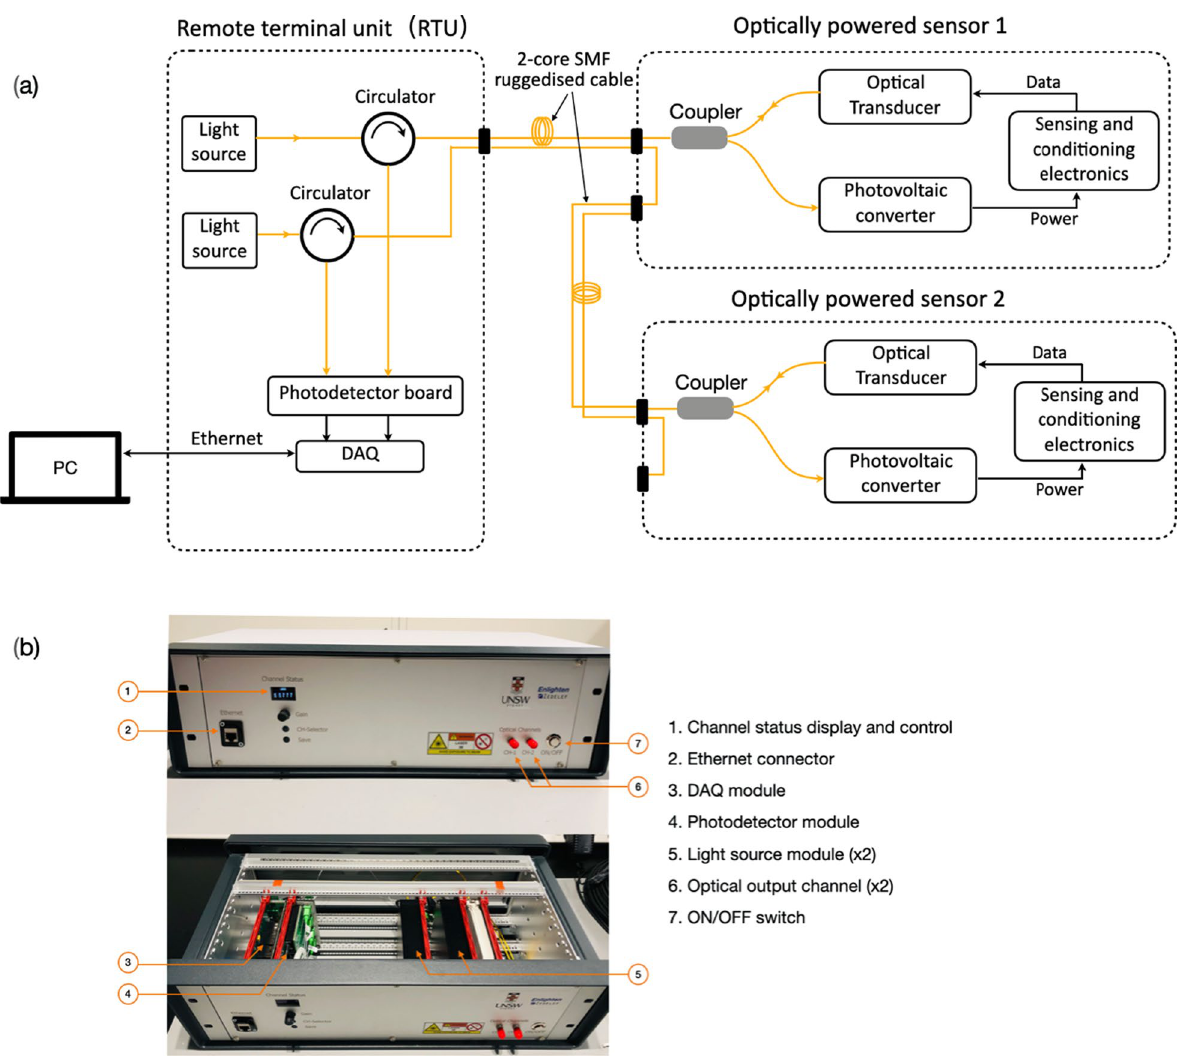
Fig. 4 RTU block diagram and its connection with two optically powered sensors (in daisy-chain configuration) and RTU and its constitutive